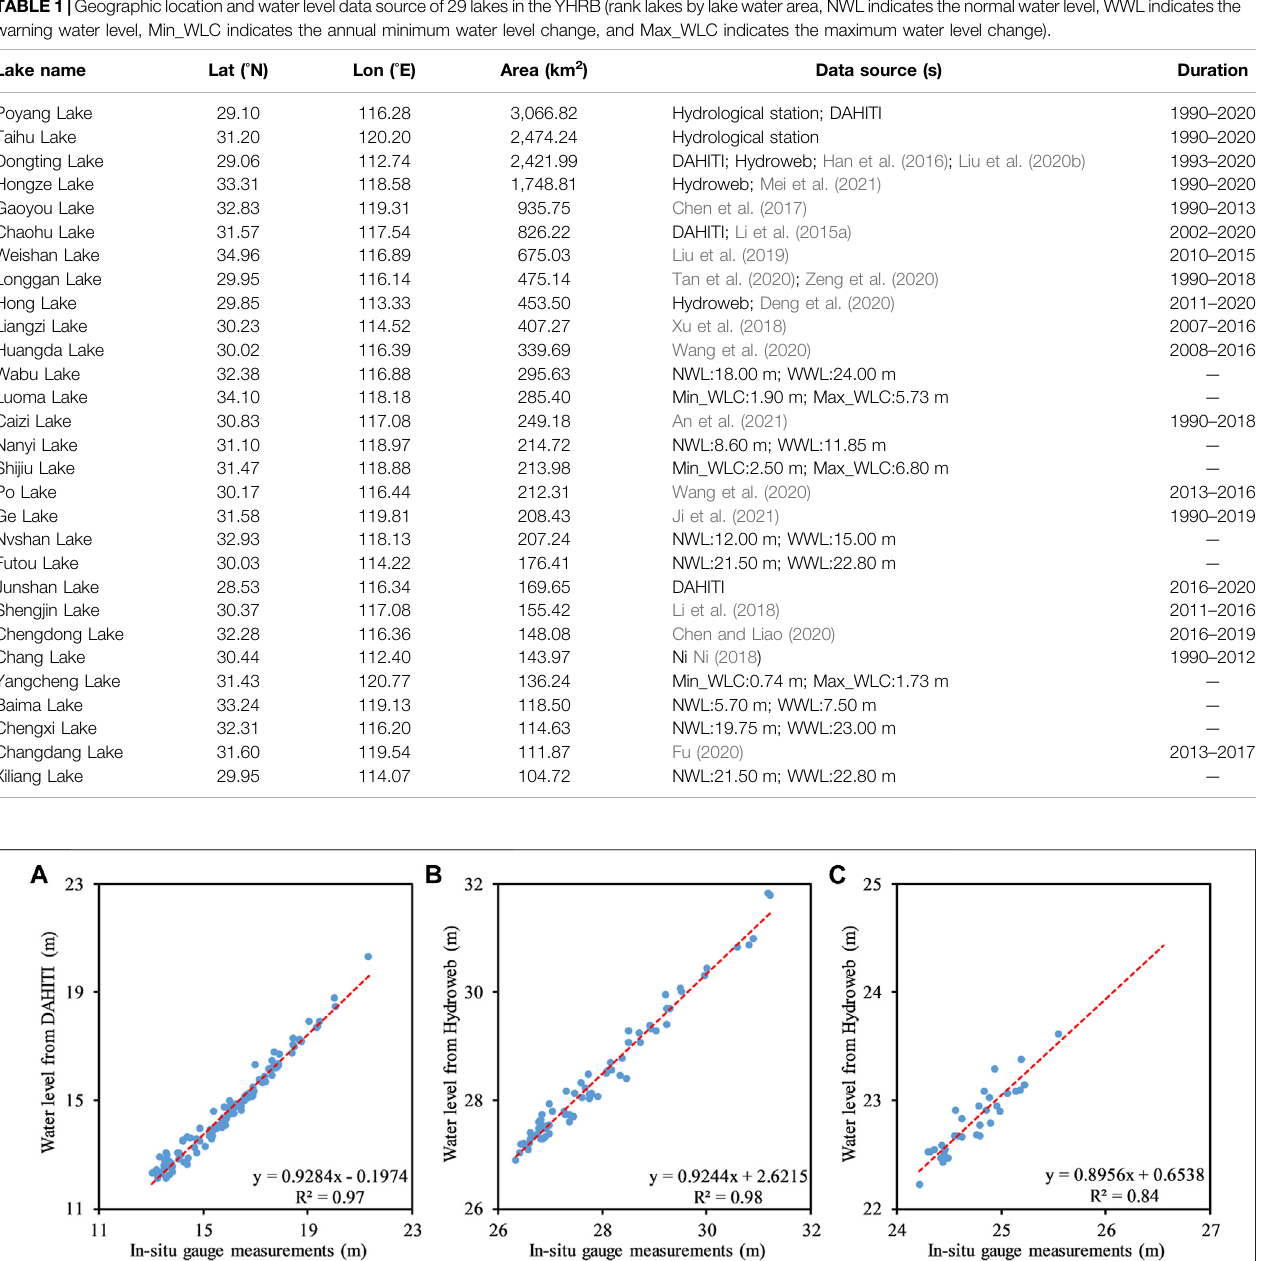
Frontiers in Environmental Science |